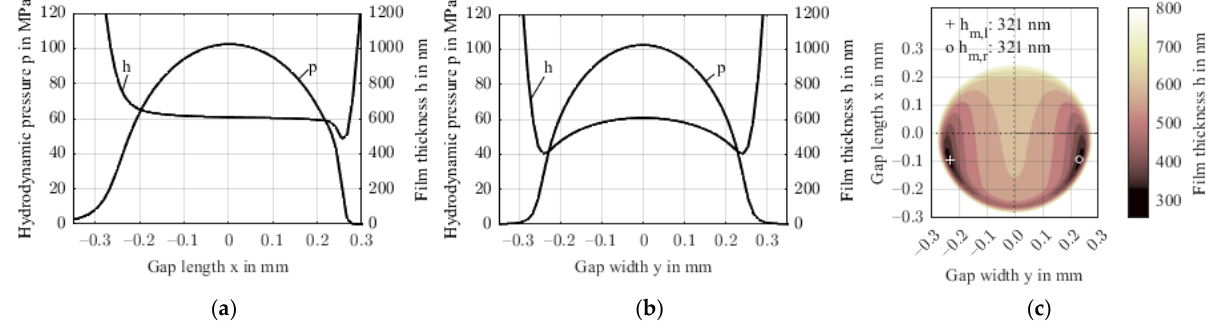
( b ) Figure 18. Cross-sectional microscopy of the fiber orientation in an injection-molded tribometer sample made of PA66 with 30 wt% glass fibers ( a ) and fiber content and orientation ( b ). As fiber content increases closely below the surface, the effect on the stiffness is small. The effective stiffness is also not significantly affected, because the fiber orientation rotates only around an axis in the isotropic plane. Hence, the results shown in Figure 19 compare to Study 2.1 (Figures 10 and 11) with a minimum film thickness of 321 nm and a maximum hydrodynamic pressure of 102 MPa. Figure 20 shows the stress distribution in the FRP substrate material. The stress distribution shows an almost isotropic behavior. Due to the unreinforced